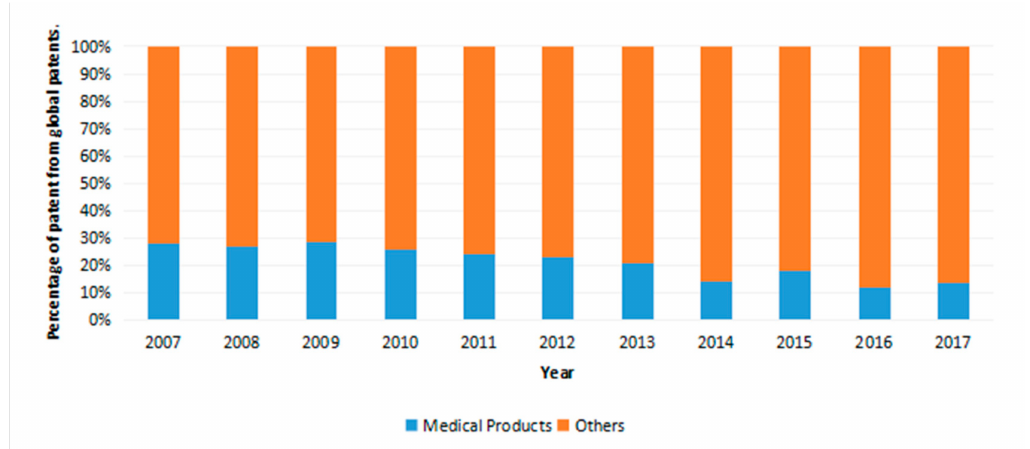
Figure 6. Total patents registered globally for silver used in the medical field compared to all other